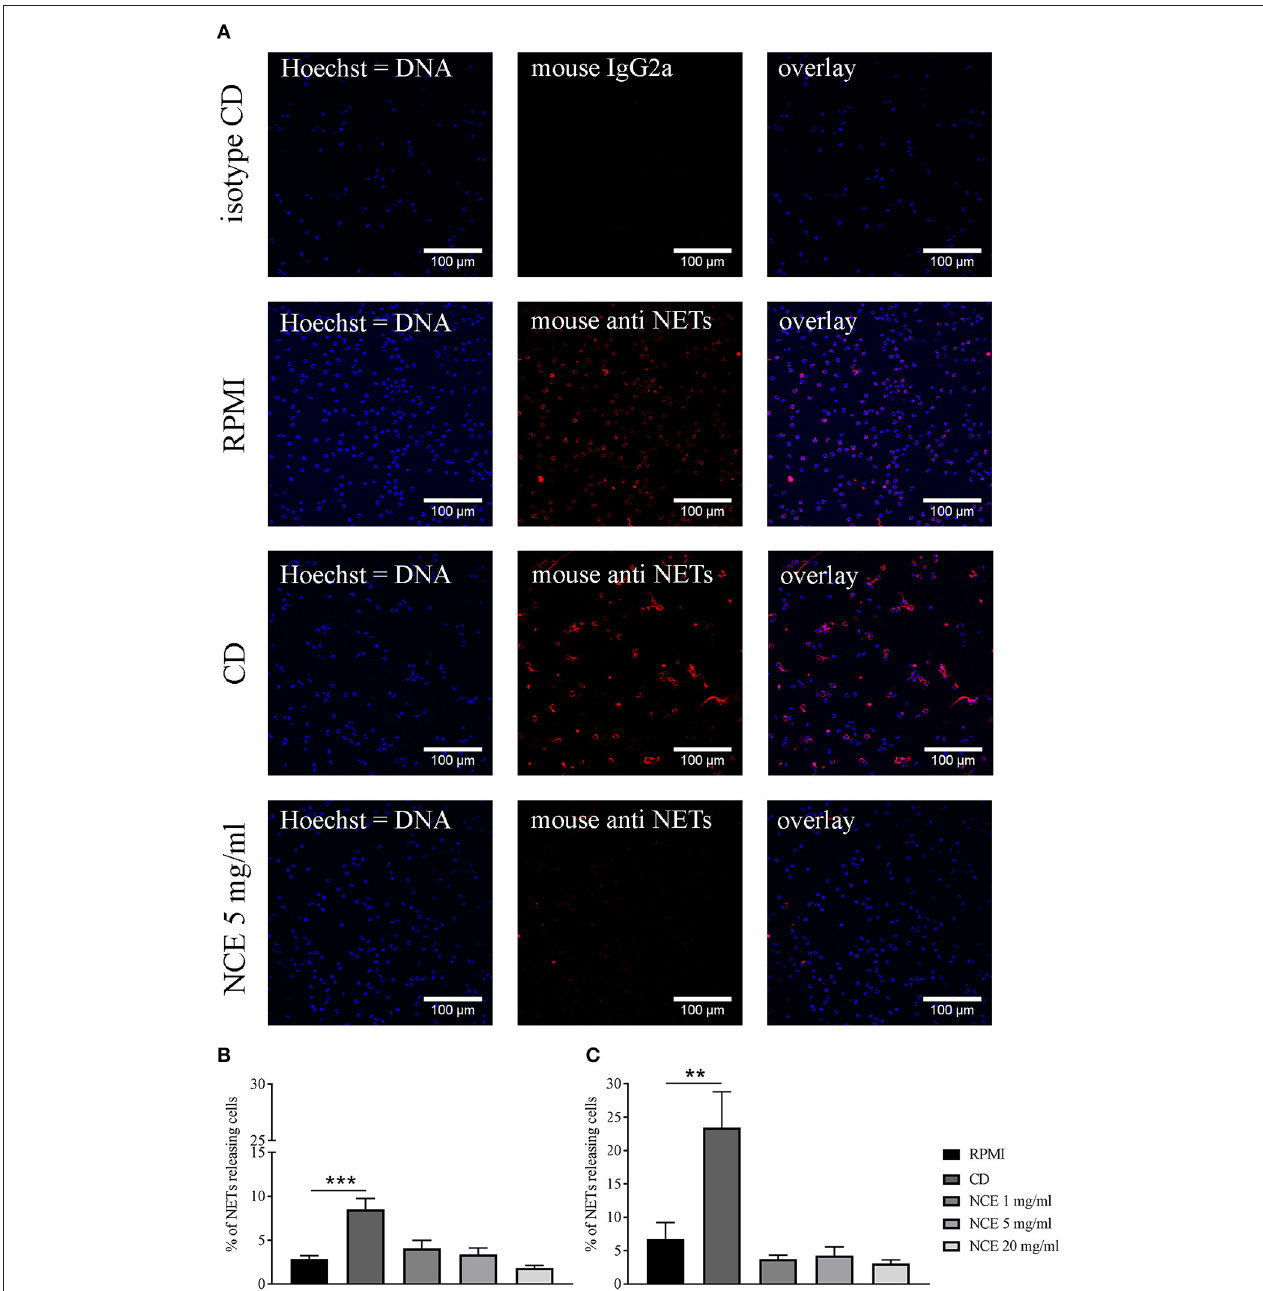
FIGURE 9 | Formation of bovine neutrophil extracellular traps (NETs) after 90min and 4h stimulation with natural crude extract (NCE). Bovine neutrophils were stimulated with methyl- β -cyclodextrin (CD) as a positive NET inducer, RPMI medium as a negative control, and different concentrations of NCE. NETs were visualized with immunofluorescence microscopy after adjustment to an isotype control. Representative pictures are presented in (A) . NCE-treated samples showed no NET induction (A) . Images were quantified using ImageJ program. (B) Samples were incubated for 90min. (C) Samples were incubated for 4h. There was no significant difference between RPMI-treated groups and NCE-treated groups independent of concentration and time ( n = 5). A total of six randomly selected images were taken in each experiment for each sample. All data are shown as means ± SD. Statistical analysis was done using one-way ANOVA repeated measurement comparing to RPMI control followed by Dunnett’s multiple comparisons test. ** P < 0.01 and *** P < 0.001 were considered significant. ( Figure 9 and Supplementary Figure 5 ), and therefore, it is of